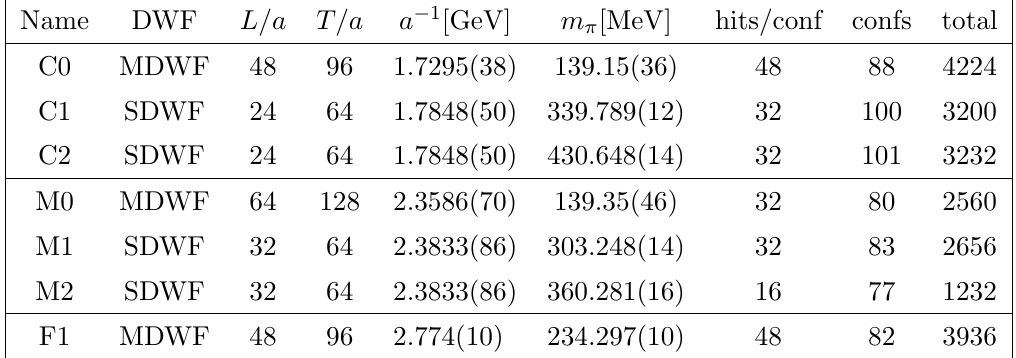
Table 1 . This table summarises the main parameters of our N f = 2 + 1 ensembles. C stands for coarse, M for medium and F for (cid:12)ne, MDWF for M(cid:127)obius and SDWF for Shamir DWF. The columns \hits/conf" and \confs" give the number of measurements on a given con(cid:12)guration and the total number of con(cid:12)gurations used, respectively. The column \total" gives their product which is the total number of measurements carried out.